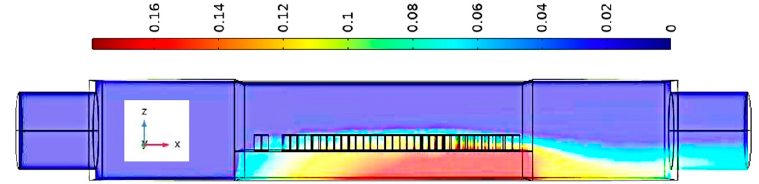
Figure 13. Temperature distribution along the flow path at mid-section.